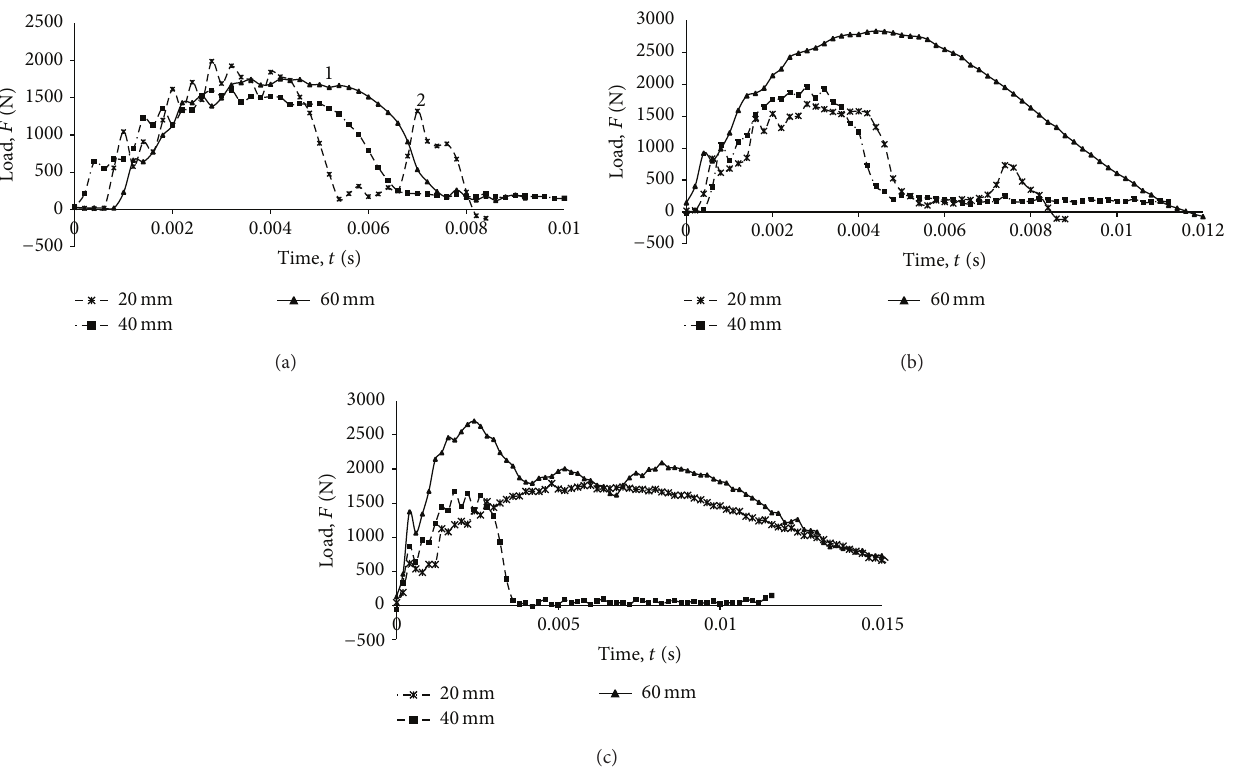
Figure 5: Load versus time plots for sandwich panels subjected to (a) 15 J, (b) 30 J, and (c) 45 J of impact energies. Point 1: upper skin failure; point 2: penetration at impact region.